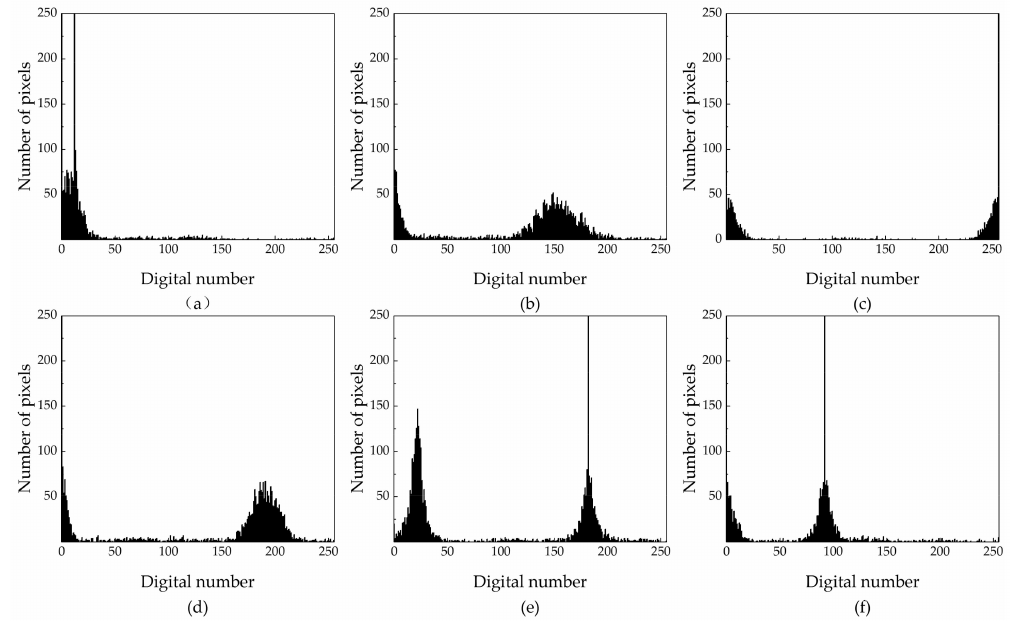
Figure 5. Grey histograms (( a – f ) represent the grey histograms of feature maps 1, 2, 3, 8, 10, and 11, respectively. The grey histograms of feature maps 5, 6, 7, and 9 are similar to the grey histogram of feature map 3; and the grey histograms of feature maps 4 and 12 are similar to the grey histogram representing feature map